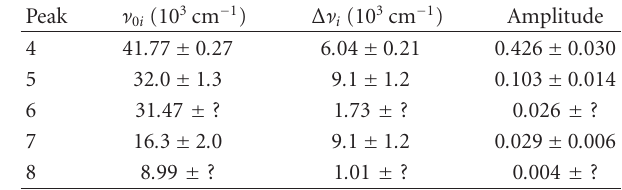
Table 1: Best-fitted parameters of the optical absorption spectra of thin sample of topaz heated at 600 ◦ C for Gaussian line shapes. The Gaussian amplitudes are given in absorbance units.